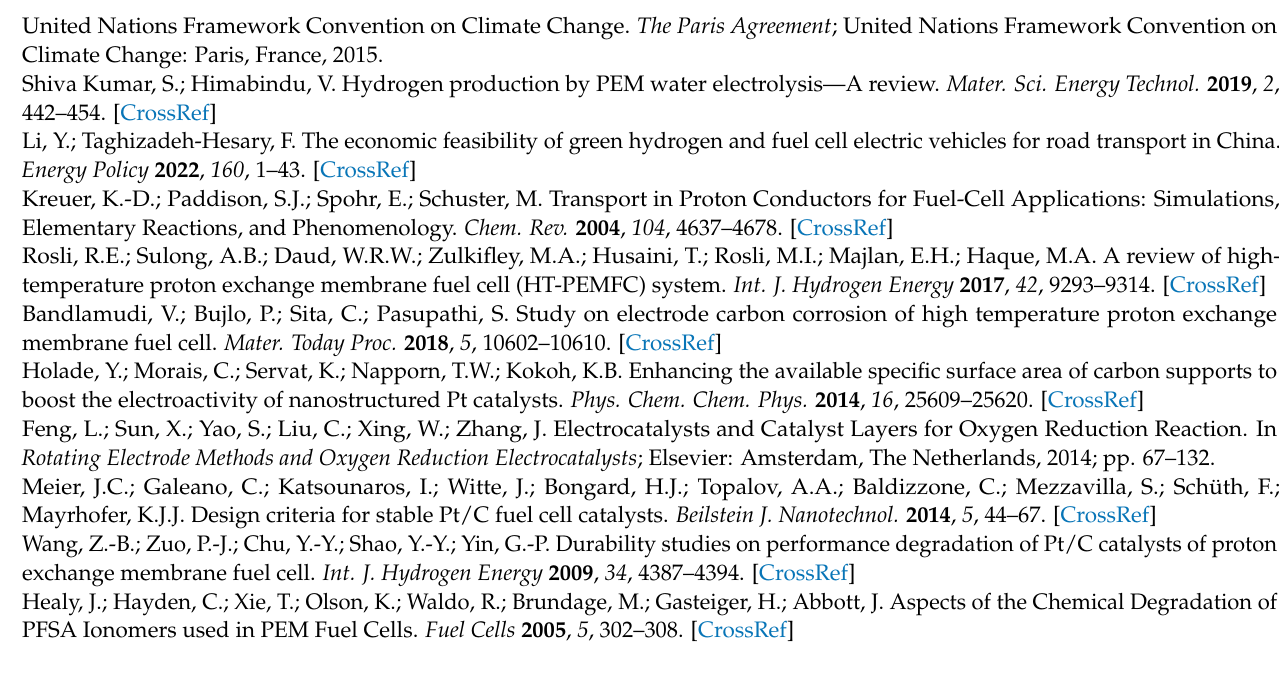
Figure S2: Thermogravimetric profile of Pt/C ref in oxygen at a heating rate of 10 ◦ C min − 1 in the